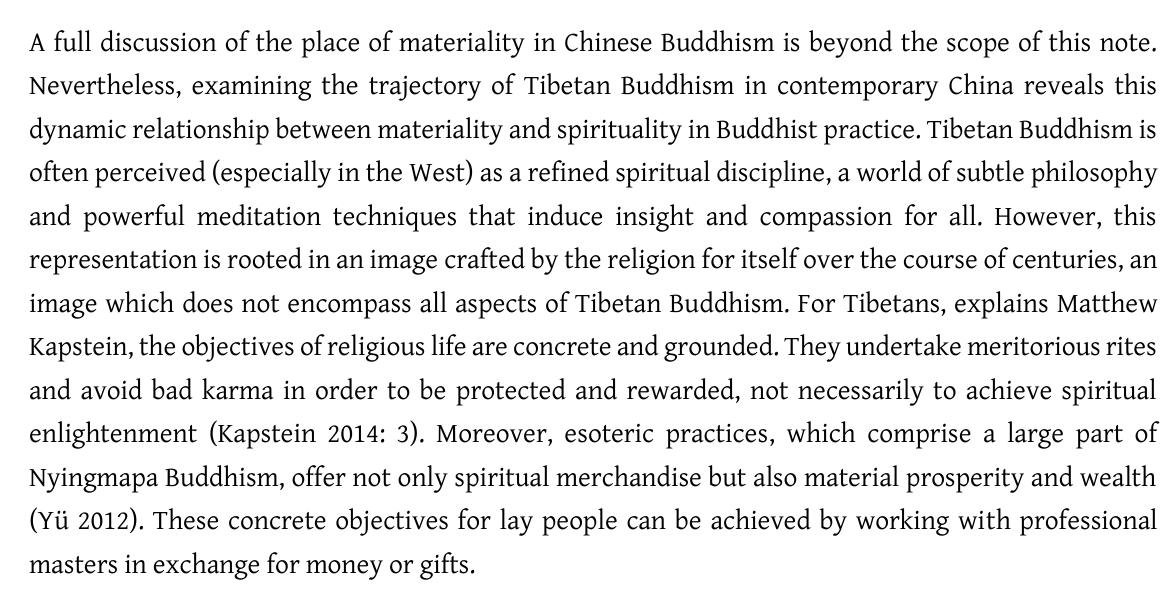
Figure 1: Face masks sold by the group. (Photo by the